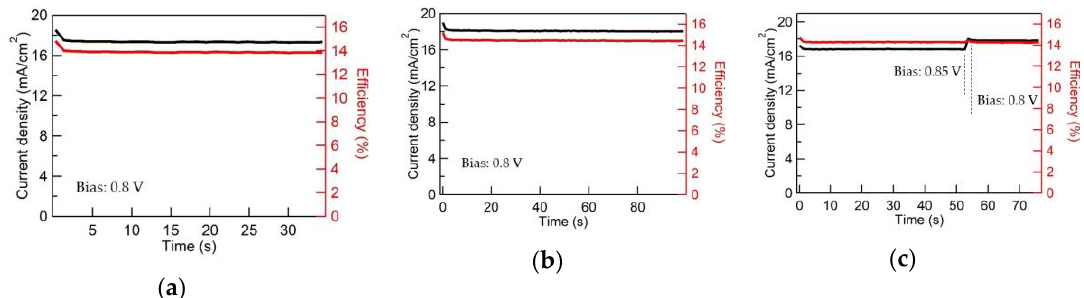
Figure 13. The stabilized photocurrents and efficiencies for the representative MAPbI 3 cells with ( a ) CCO, ( b ) 5% Mg:CCO, and ( c ) 10% Mg:CCO HTLs. In ( a , b ), the applied bias is at 0.8 V. In ( c ), the applied bias is initially at 0.85 V. After 50 s, it switches to 0.8 V.